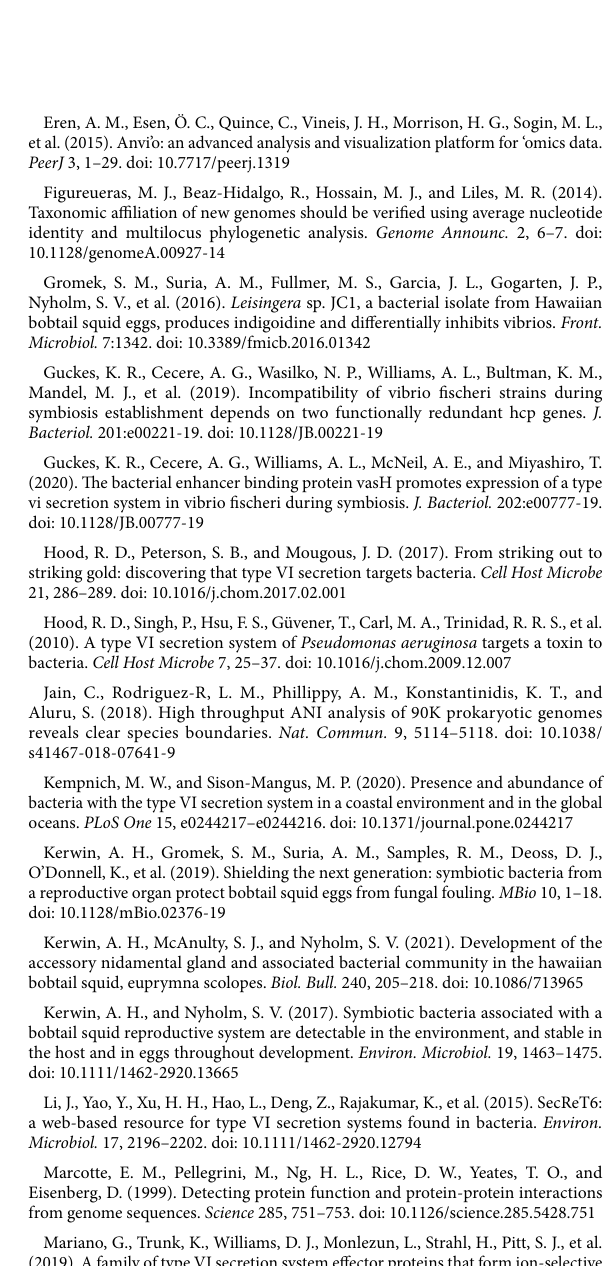
of V. fischeri ES114 do not show any GFP fluorescence in imaged colonies. Strains that allow growth of V. fischeri ES114 show GFP fluorescence in imaged colonies. Representative images are shown from three experimental trials, where each trial contained three resuspensions per strain, prepared from different